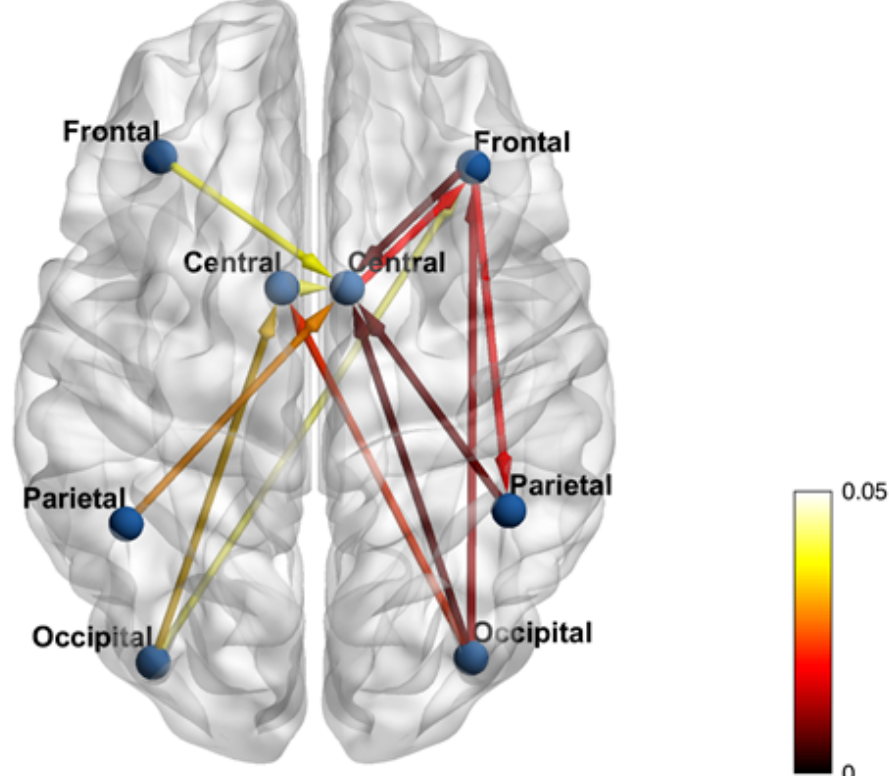
Figure 2. Statistically significantly different edges ( p < 0.05) in controls vs. PD participants as calculated from the GC matrices. Edges values are derived from the Mann-Whitney-Wilcoxon test, which compares the non-threshold connectivity matrices between the two groups. Only the p -values of the significant connections ( p < 0.05) were plotted onto the MRI template. Colorbar represents p